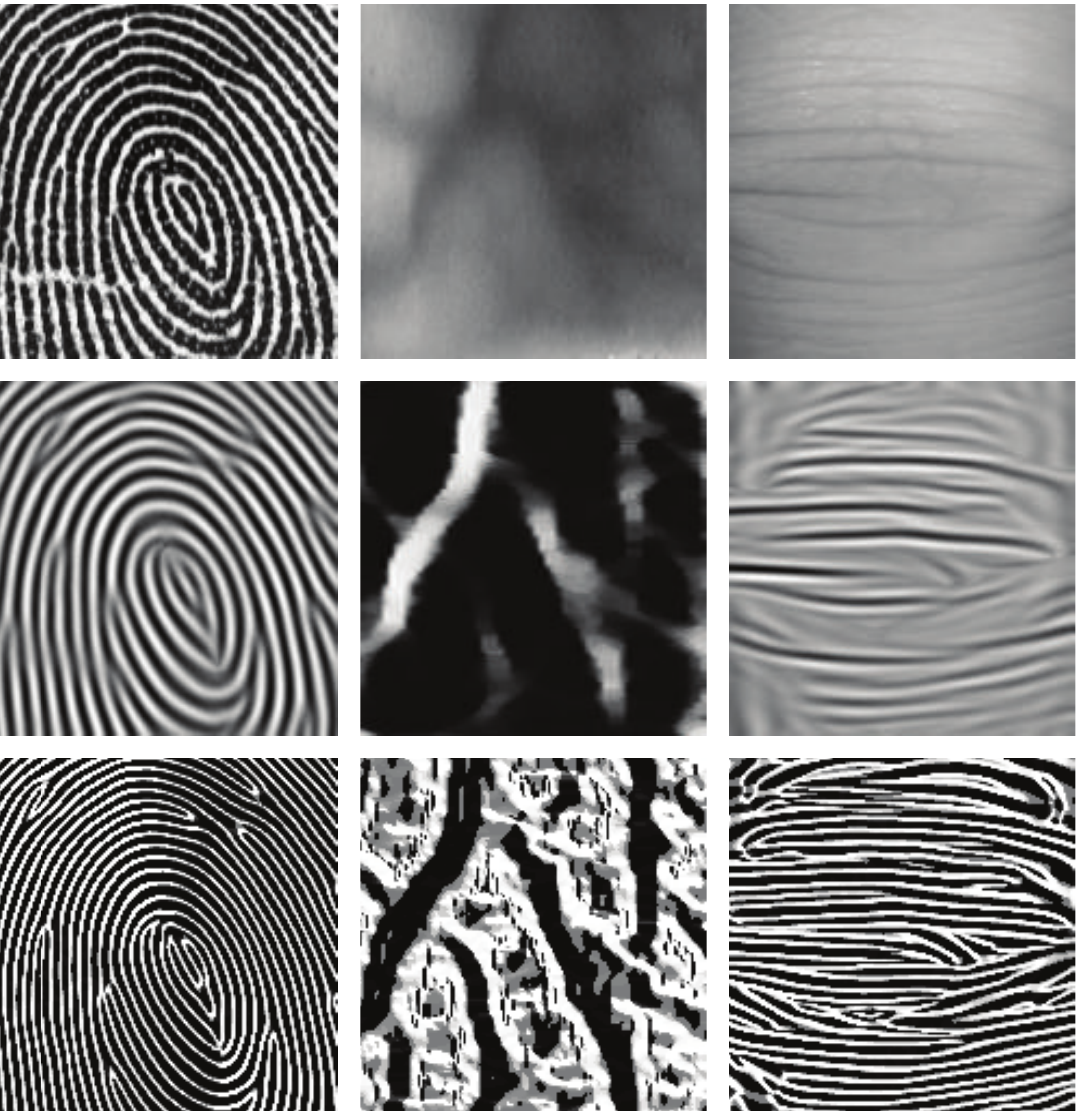
Figure 3: Gabor Ordinal Measures feature maps of the FP, FV, and